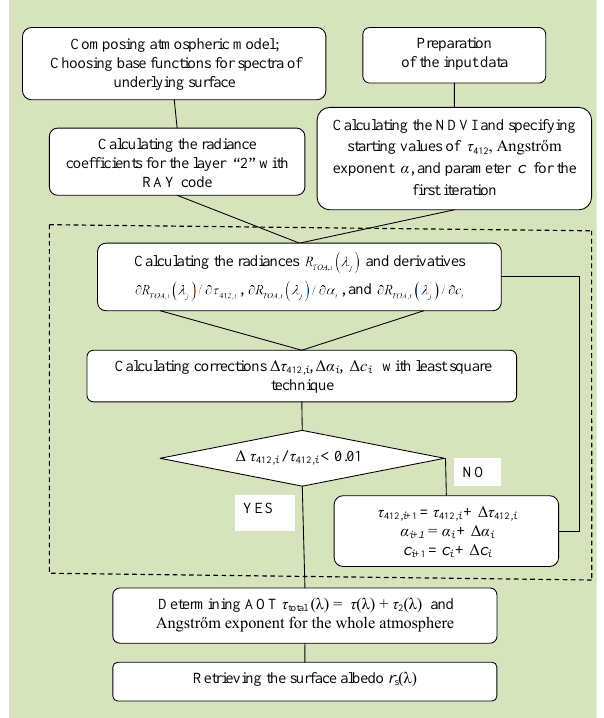
Fig. 1. Flow chart of the FAR